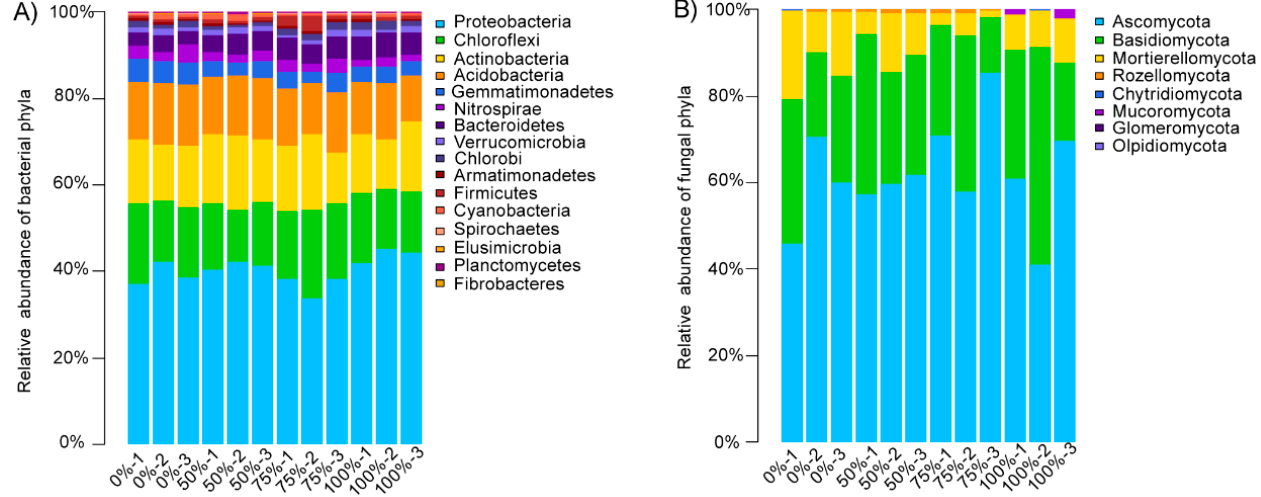
Figure 2. The relative abundance of the bacterial ( A ) and fungal ( B ) phyla at different levels of straw addition. The relative